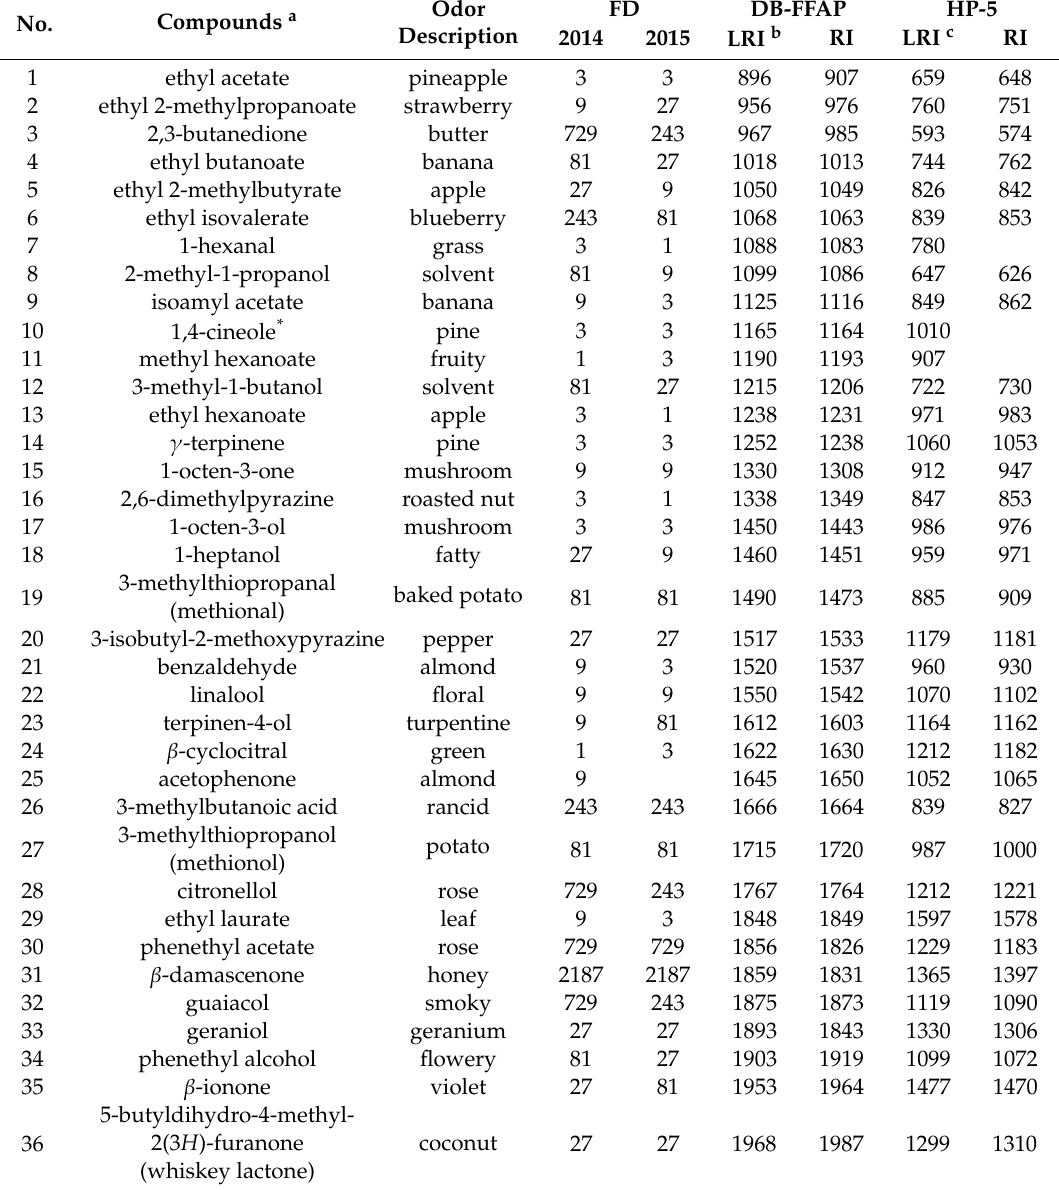
Table 1. Aroma compounds identified in Marselan wine by